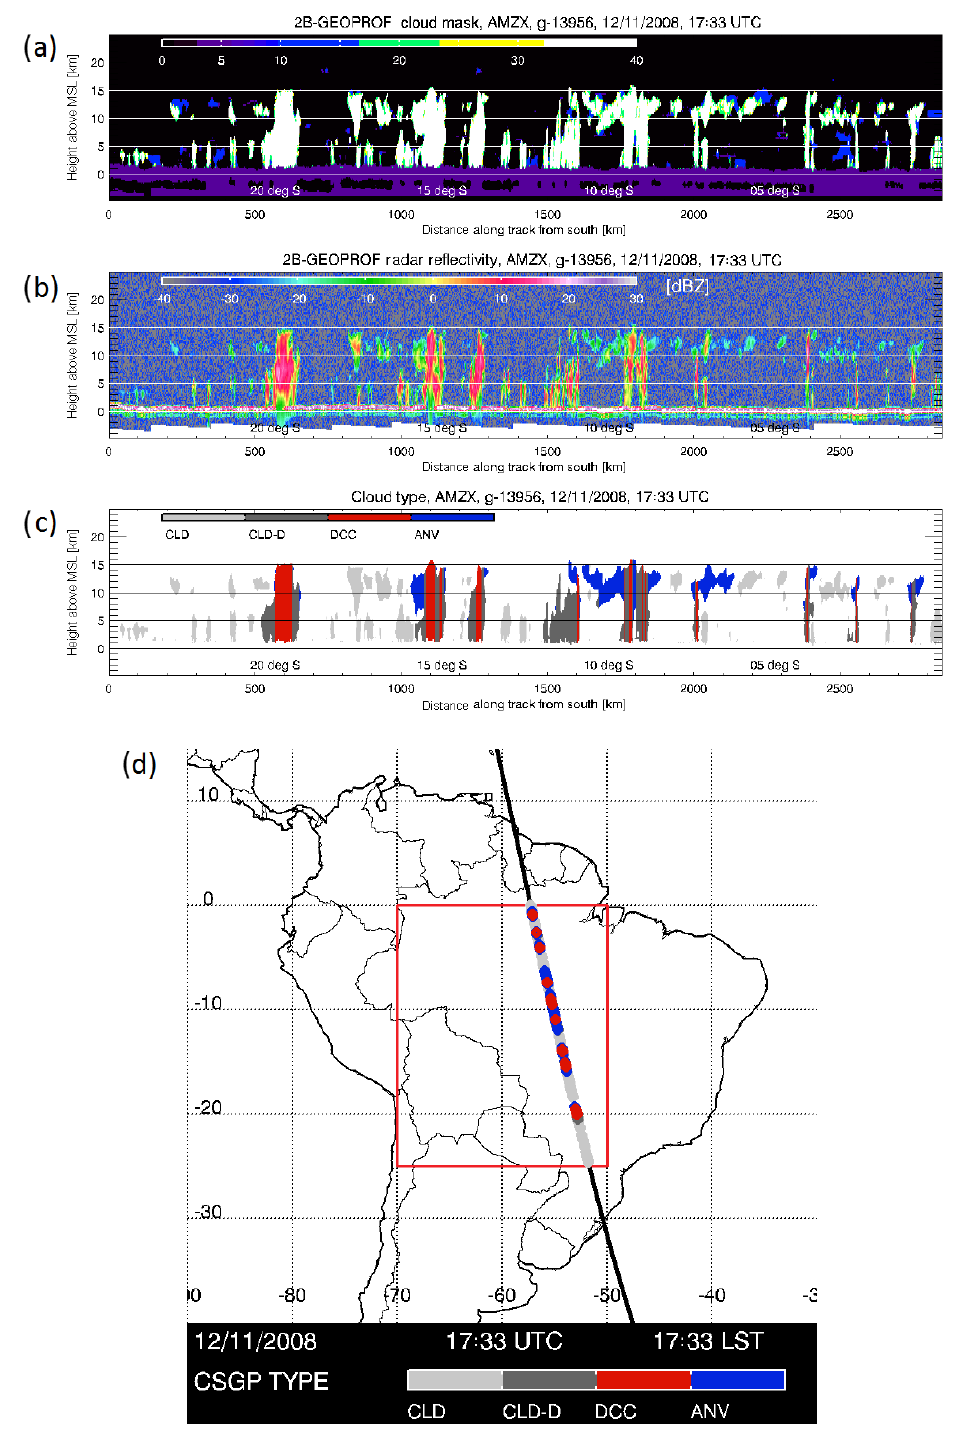
Figure 1. (a–c) Example of a CloudSat cross-sectional observation of afternoon convection on 11 December 2008 at approx. 17:33UTC (13:33LST). Left-to-right on the x axis corresponds with south-to-north. (a) is the cloud mask product from 2B-GEOPROF, with colors representing the cloud mask value corresponding with certainty of cloud identification; (b) is radar reflectivity; and (c) is cloud type. Red indicates DCCs, blue indicates anvils, dark gray indicates clouds attached contiguously with DCCs, and light gray indicates other clouds. (d) Map of northern South America with the study region (25–0 ◦ S, 70–50 ◦ W) marked with the red box. The heavy black line crossing the study region indicates the path of the CloudSat swath shown in panel (a) . The dominant cloud type observed by CloudSat along the path is indicated by the colored